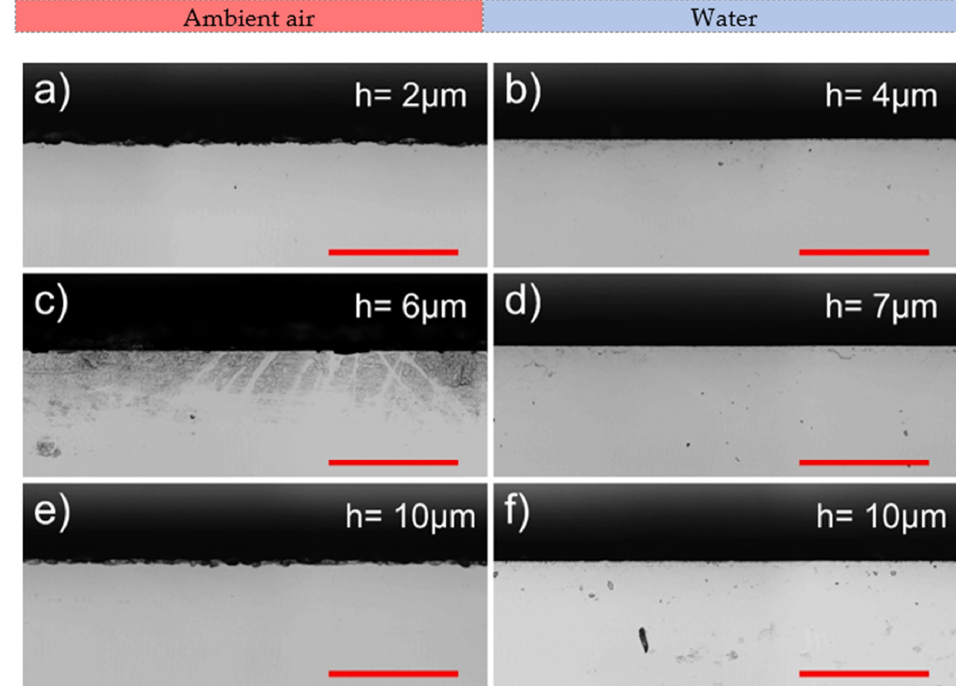
Figure 11. Optical micrographs showing cut edges at the front surface produced in ambient air (to the left) and water (to the right). Rows represent different hatch distances: ridge-free ( a , b ), intermediate ( c , d ), and optimal ( e , f ). The scale bars represent 200 µm and apply to all panels in the figure. Cutting in ambient air produced rougher cut edges. The smallest value of 4.3 ± 1.8 µm was measured at the optimal hatch. Transition to smaller hatch values increased the average chipping width by up to 49% to 6.2–6.4 µm, depending on the hatch distance. Table 2. Average chipping widths.